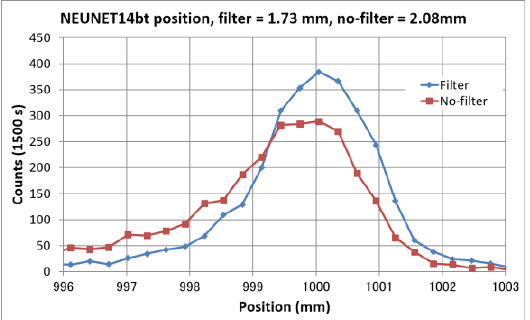
Fig. 5. Position distributions with the 13-clock filter and the no